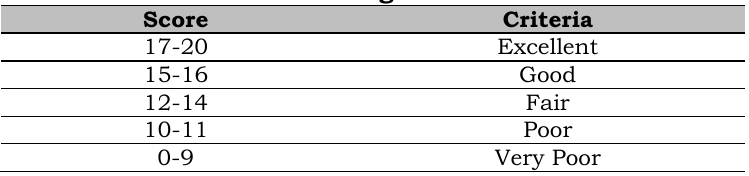
Figure 1. The scrore of students pre-test and post-test of ANKAPIN Maritime English Table 1: Rating